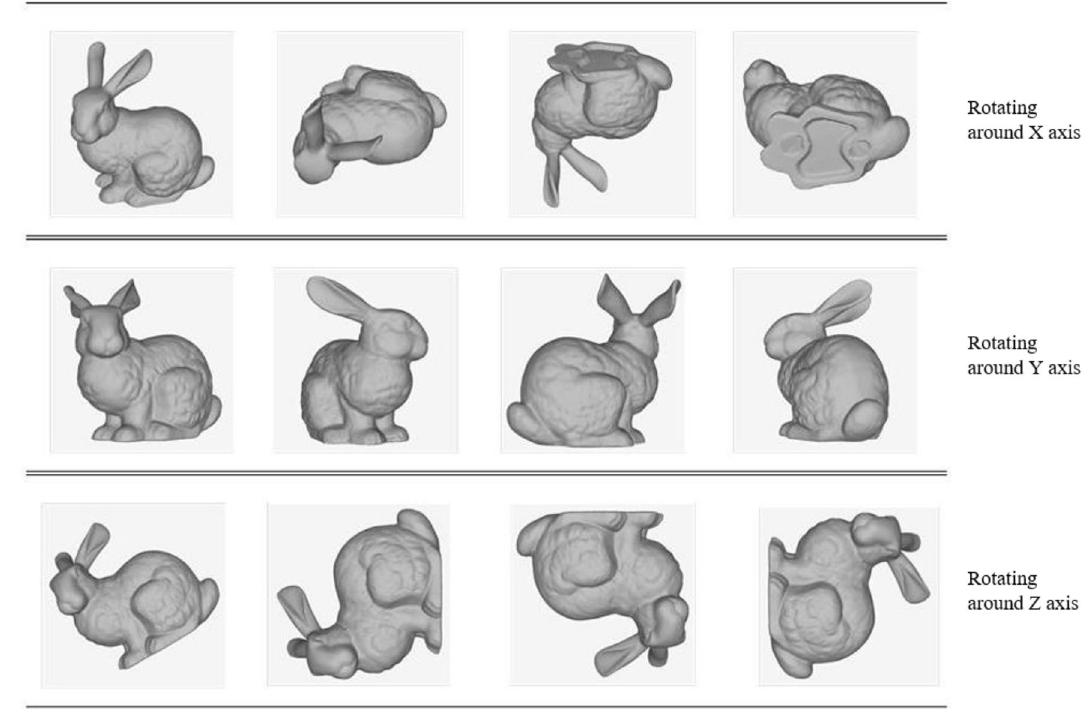
Figure 17. Schematic diagram of bunny model rotating around X/Y/Z